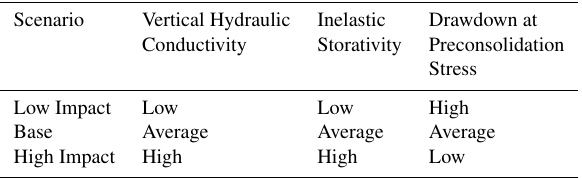
Table 1. Summary of direction of parameter variation for Jasper Compaction Model sensitivity analysis.